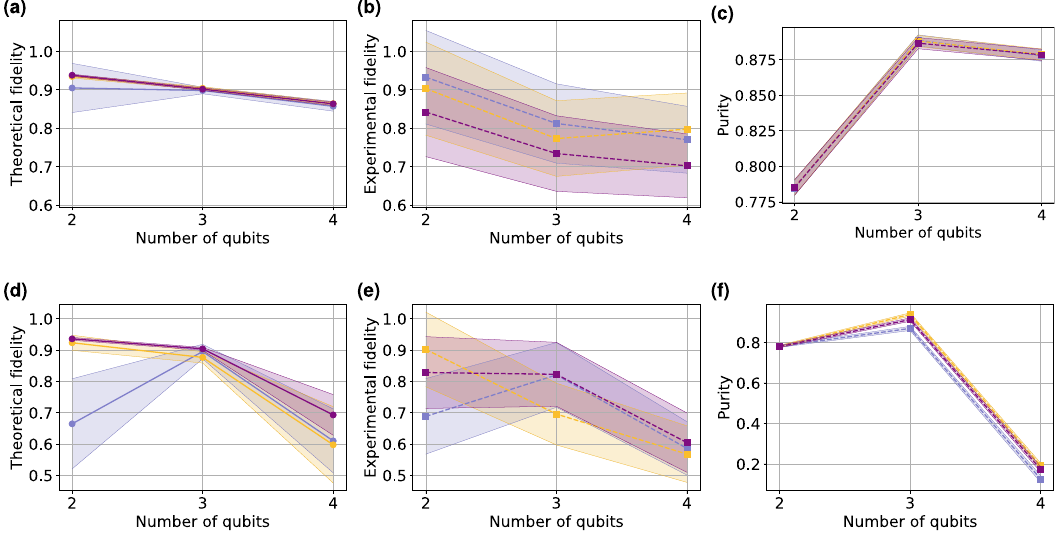
(cid:2) (cid:4) (cid:2) as a function of the number of qubits. a Theoretical 3